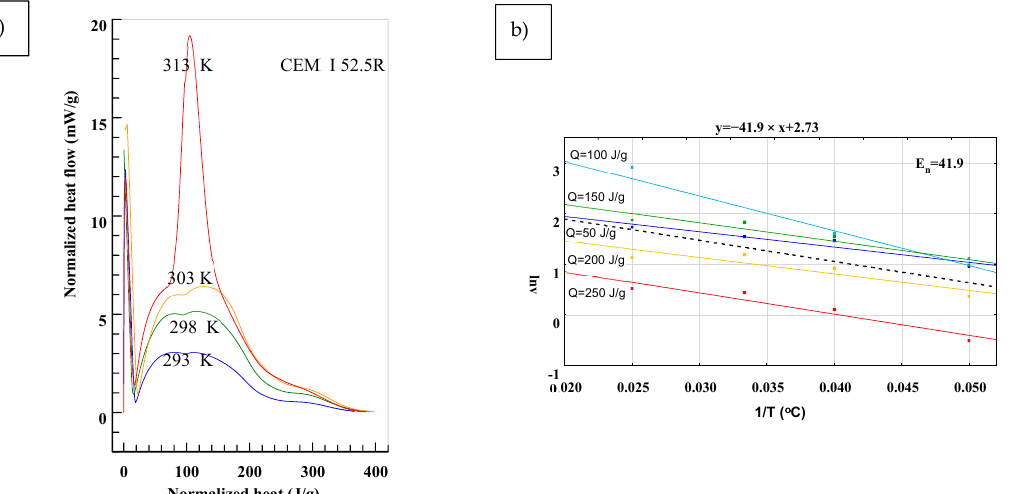
Figure 3. Determination of the En from the Equation (2) for CEM I 52.5 R. ( a ) Normalized heat flow in comparison to total heat generated for different temperatures, ( b ) Values of En for different temperatures and it’s representative value calculated using least-square method.